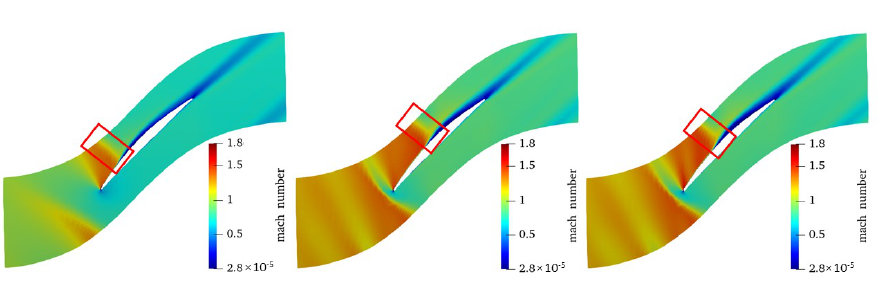
Figure 20. Mach number distribution of the three blades at the near-stall condition at 100% speed: sample_B ( left ), baseline ( middle ) and sample_W ( right ).